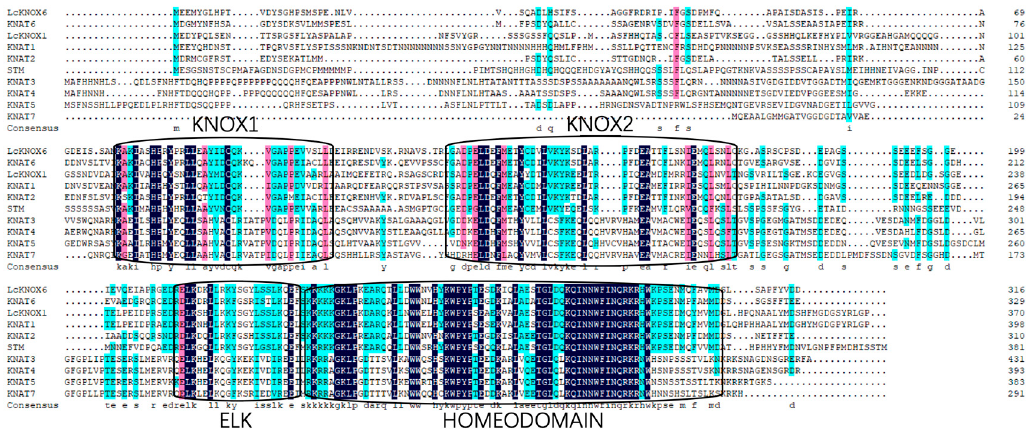
Figure 1. The sequences of the LcKNOX1 and LcKNOX6 proteins.